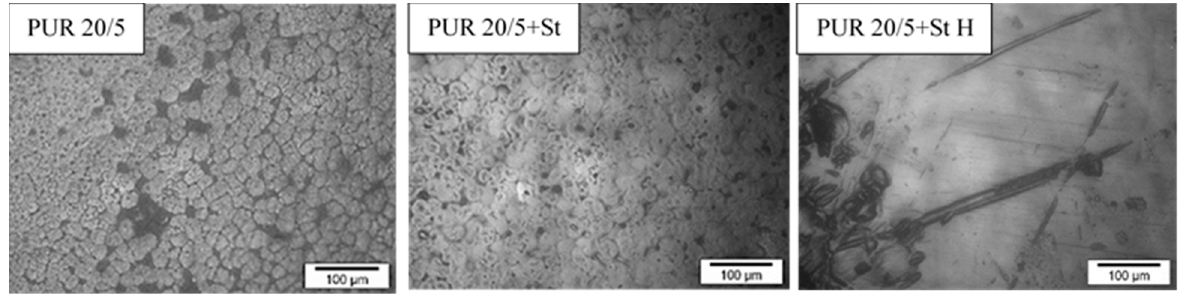
Figure 8. Optical microscope micrographs of the surface of PUR 20/5, PUR 20/5+St and PUR 20/5+St H.